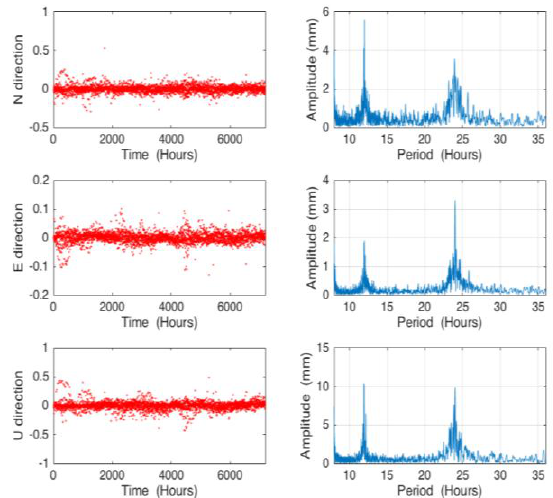
Figure 1. Coordinate time series (left) and spectrum analysis (right) of GDSG station